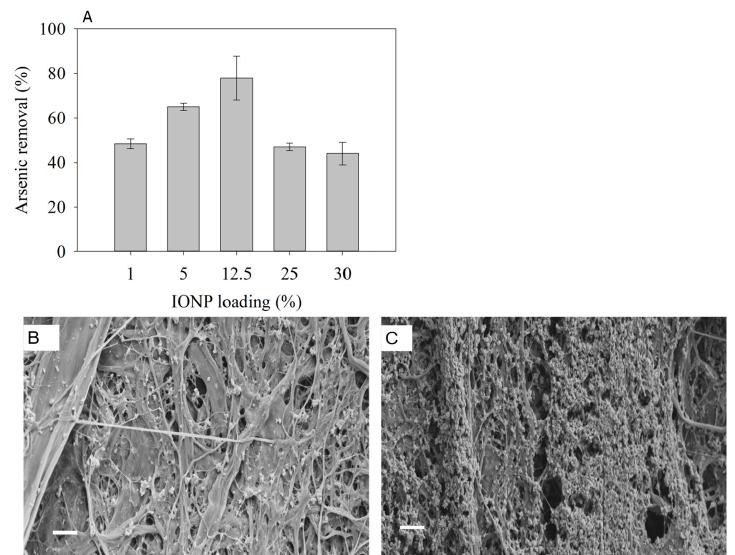
Figure 4. As(V) adsorption with different wt.% of IONPs in CNF-IONP aerogel. The error bars represent standard deviation from triplet measurements ( A ); SEM micrographs (scale bar: 1 µ m) of 12.5 wt.% ( B ) and 25 wt.% ( C ) of IONPs in CNF-IONP aerogel.